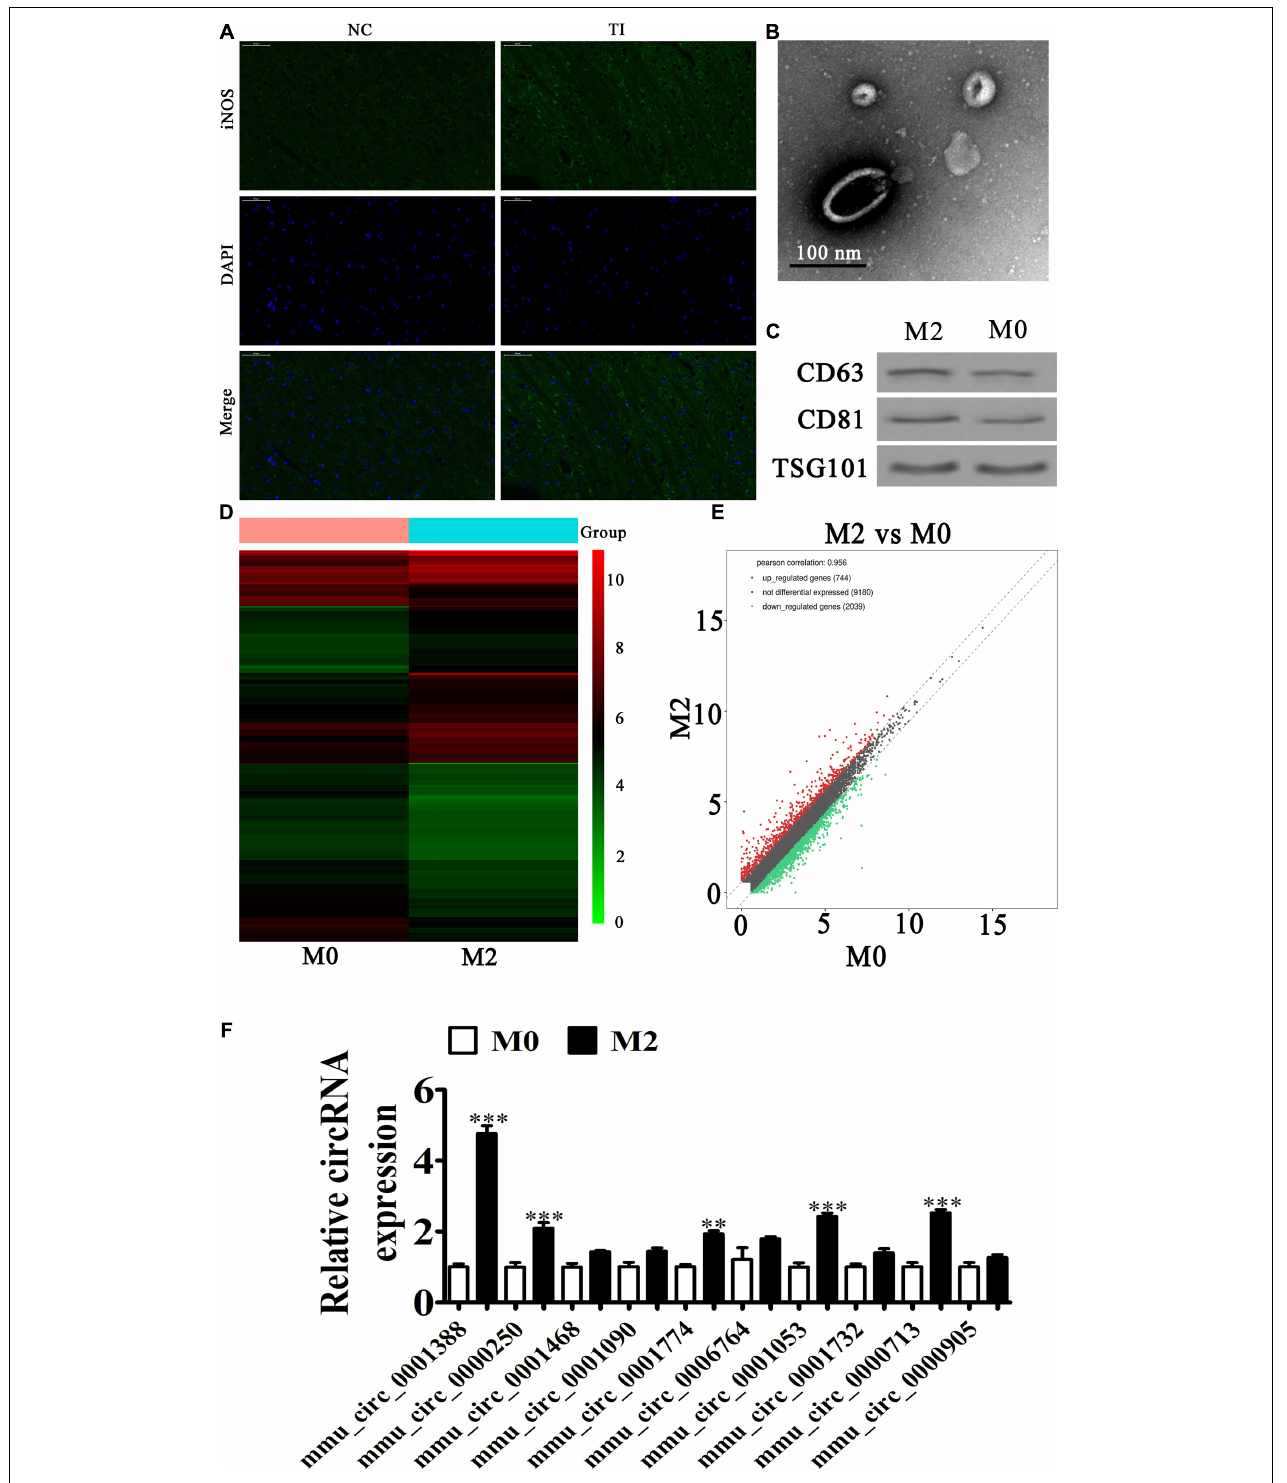
FIGURE 2 | Macrophage phenotypic transformation plays a role in regulating peritendinous fibrosis after tendon injury (TI). (A) Immunofluorescence detection showing the expression of iNOS (M1 marker). (B) Transmission electron microscopy shows exosome secretion from macrophages. (C) Western blot analysis showing the expression of exosome specificity markers (CD61, CD81, and TSG101). (D) A heat map shows the differentially expressed circRNAs. (E) A volcano plot showing the upregulation and downregulation of circRNA from M0 and M2 macrophage exosomes. (F) RT-qPCR detection comparing the upregulated expression of ten circRNAs from M0 and M2 macrophage exosomes. The results are expressed as the mean ± SD, ∗∗ P < 0.01, ∗∗∗ P < 0.001 vs. M0 macrophages.